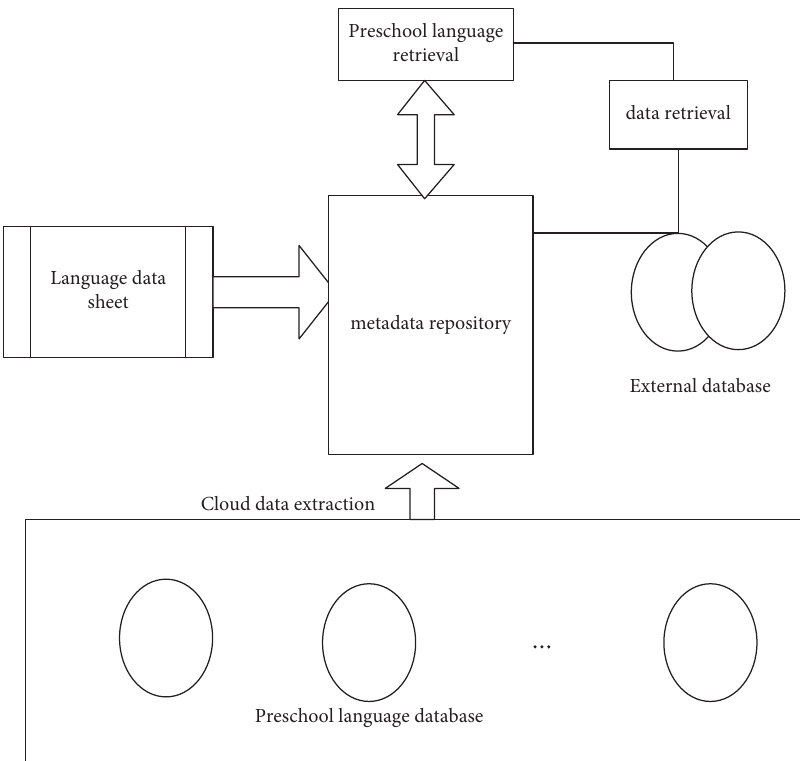
Figure 1: Schematic diagram of implementation process of metadata warehouse of preschool language education